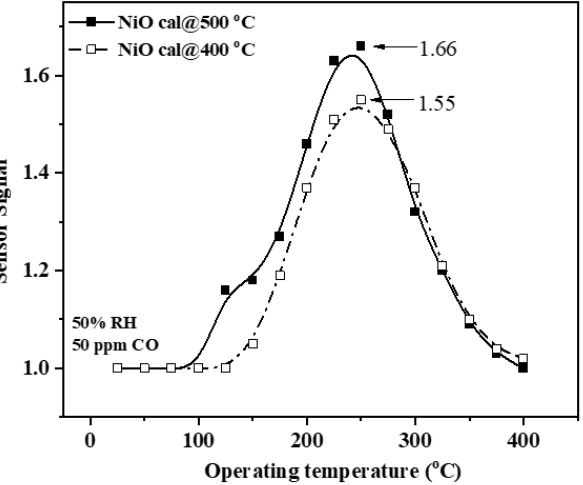
Figure 6. The sensor signal dependence with respect to the operating temperature for NiO-based gas sensors.